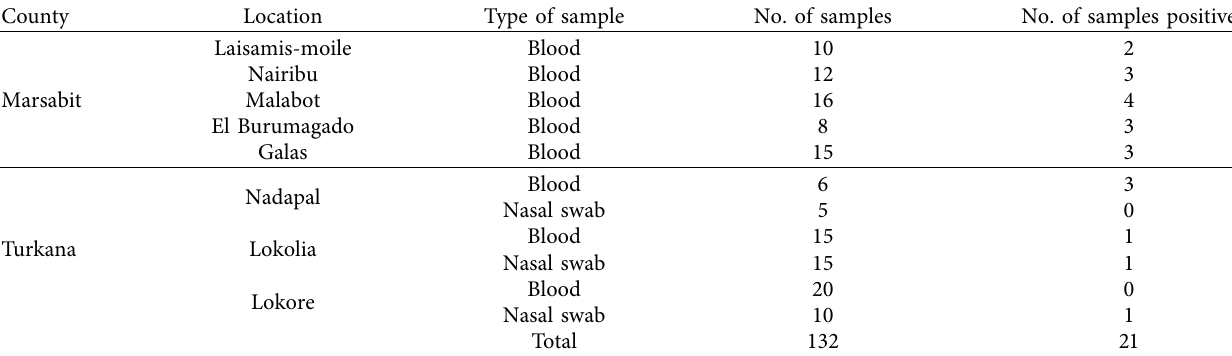
Table 2: Results of PCR analysis of the samples collected for the study